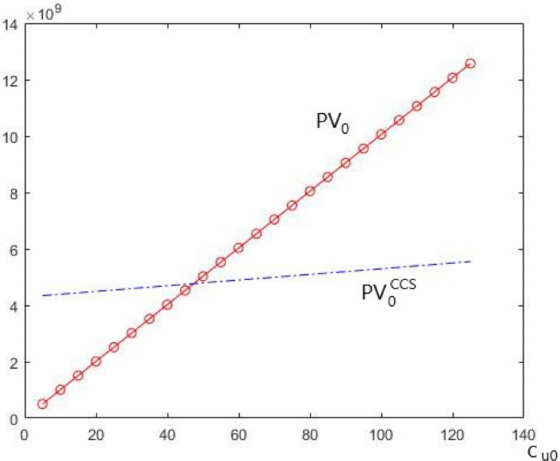
Figure 5. Threshold value c ∗ of price of CO 2 emission allowance determined based on patterns of u 0 PV 0 and PV CCS for r = 8% for the case 2 (90% carbon capture) (Source: own work). 0 At present, the price of an emission allowance on European exchanges is approx. c u 0 = 80 EUR/tCO 2 , which at current exchange rates corresponds to c u 0 = 90.6 USD/tCO 2